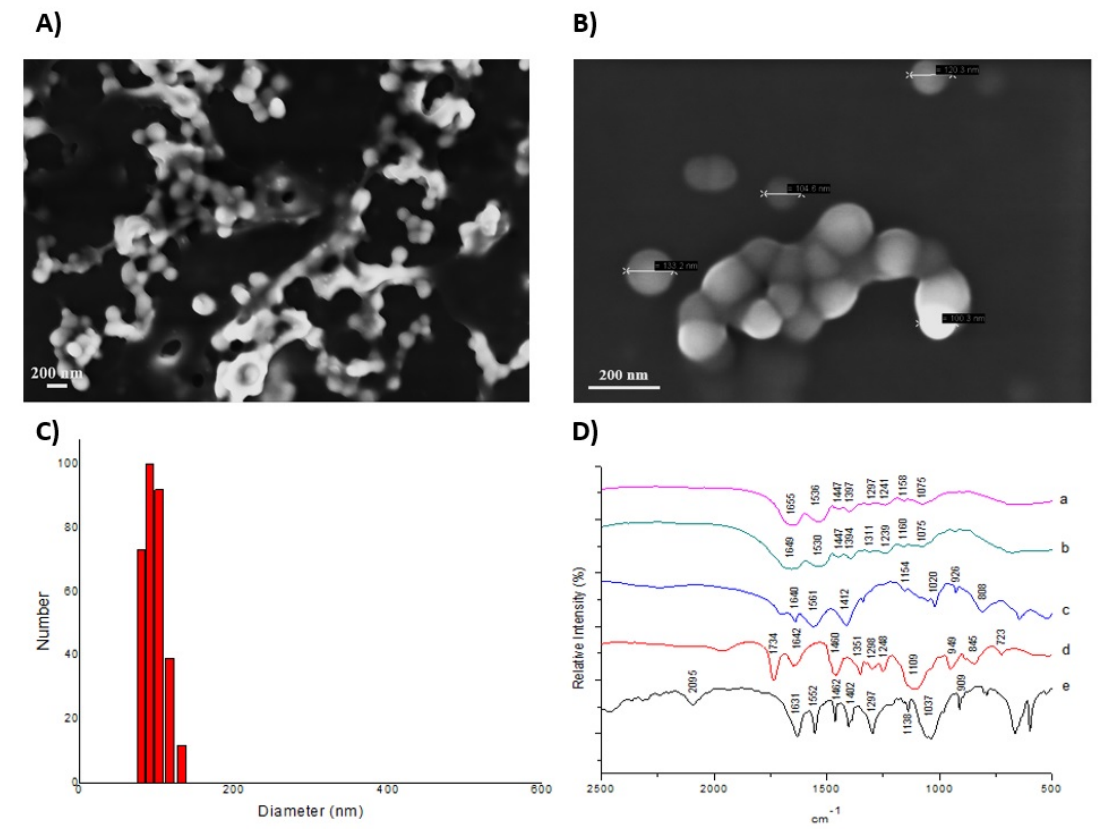
Figure 2. Characterization of ECW. ( A ) Scanning Electron Microscopy (SEM) with a magnitude of 20.00 KX, a working distance of 4.0 mm, and an acceleration voltage of 3.00 kV. ( B ) Scanning Electron Microscopy (SEM) with a magnitude of 80.00 KX, a working distance of 4.0 mm, and an acceleration voltage of 3.00 kV. ( C ) Laser diffraction obtained by crosslinking using formaldehyde and dispersing ECW in water. ( D ) Fourier Transform Infrared Spectroscopy (FTIR). ECW: TTI encapsulated in purified chitosan and whey protein isolate (1:2:2 w / w / w ). (a) EWPI: Whey protein isolate; (b) ECH: purified chitosan; (c) Tween 80; (d) TTI: tamarind trypsin inhibitor; (e) ECW: TTI encapsulated in purified chitosan and whey protein isolate (1:2:2 w / w / w ).